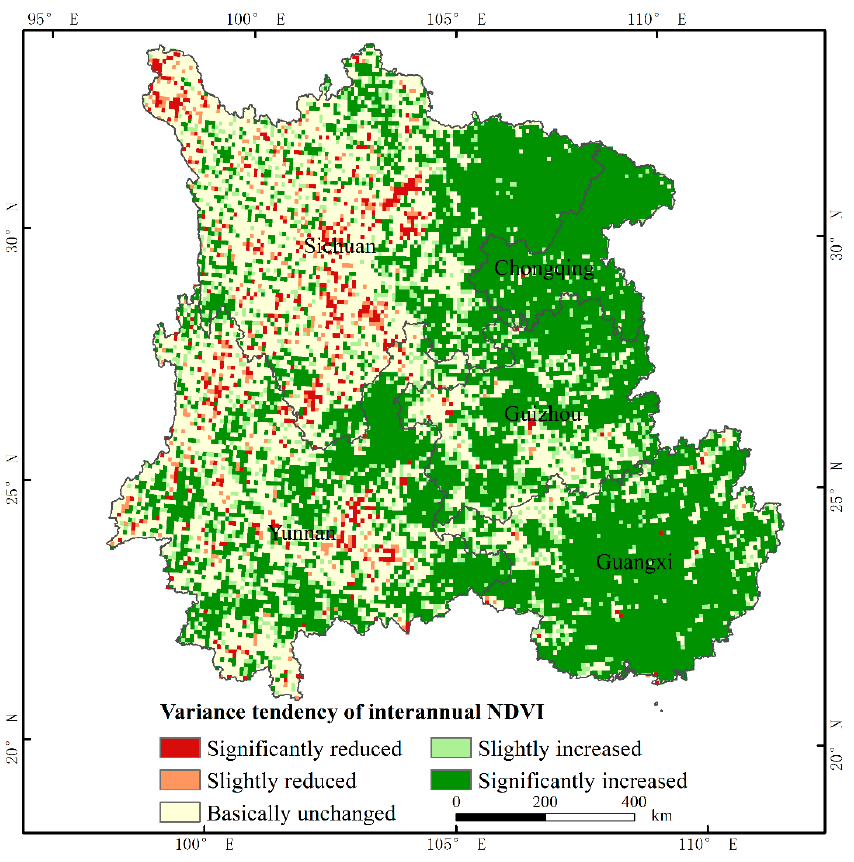
Figure 6. The long-term trend of NDVI of cultivated land ( a ), forest land ( b ), grassland ( c ) and shrubland ( d ) over Southwest China from 1982 to 2015.